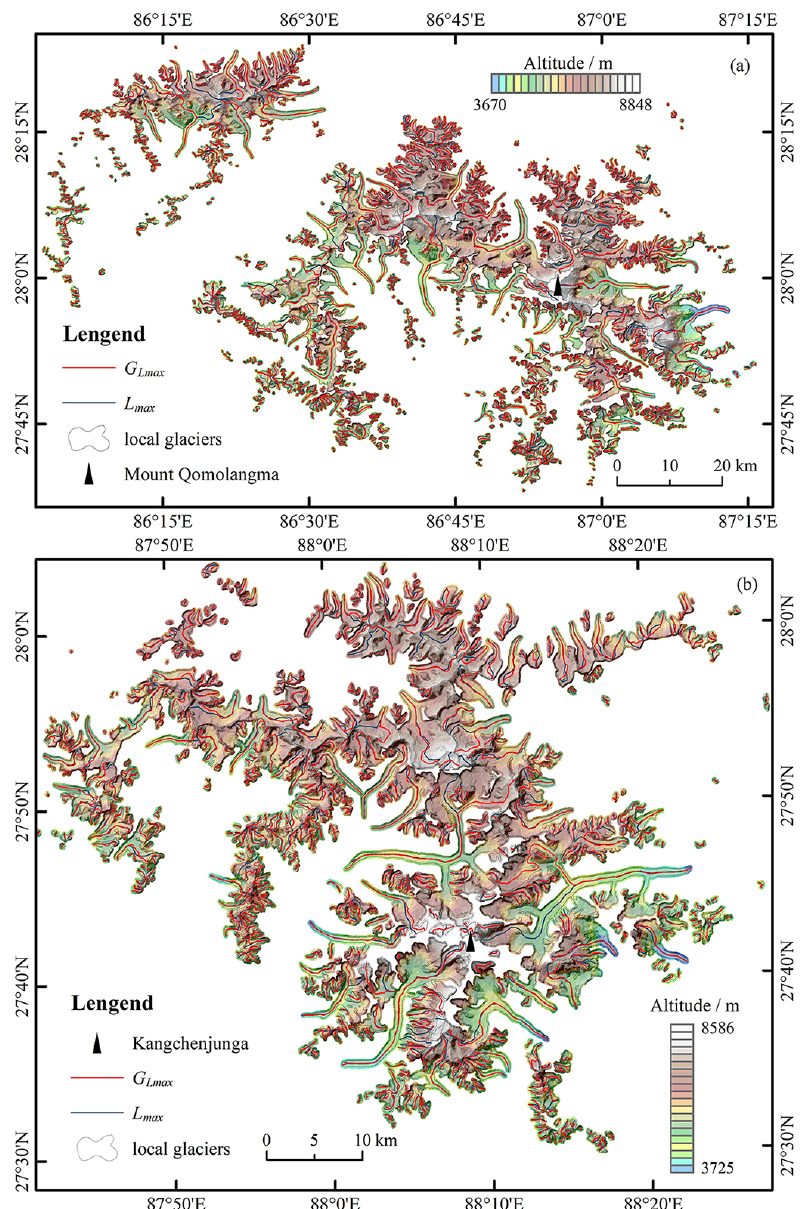
Figure 7. Visual comparison of the longest centerlines calculated in this study and by Machguth and Huss (2014) for two glacier-covered regions in the Himalayas, covering Mount Qomolangma (a) and Kangchenjunga ( b , the world’s third-highest mountain) and their surrounding areas. In the background is the DEM used for the